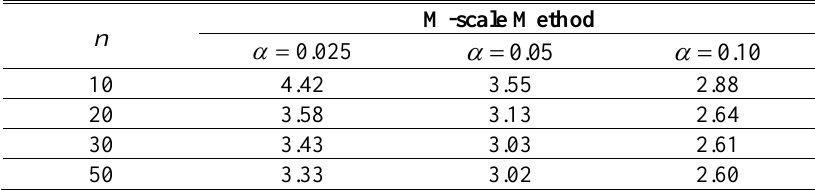
Table 1. Simulated critical values using M-scale estimator for test statistic, RT for different significance levels .